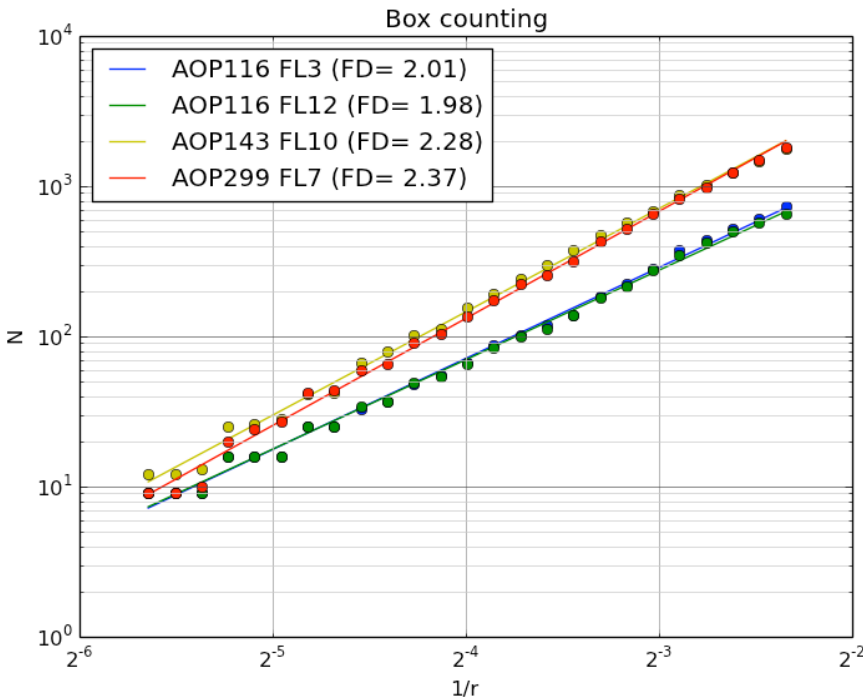
Figure 6: Relationship between the number of boxes enclosing LiDAR returns and the reciprocal of the box size, shown on logarithmic axes (box size, r, in meters). The slope of regression lines equates to the fractal dimension.